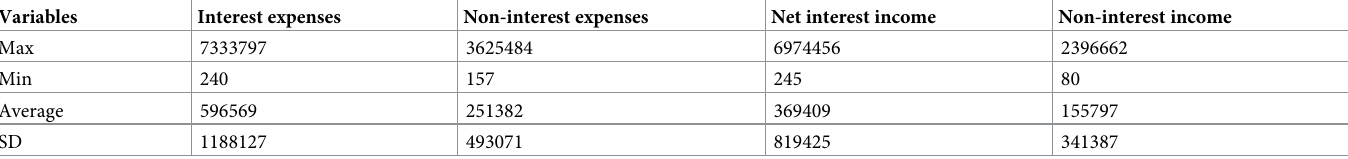
Table 3. Descriptive statistics of input-output variables (N = 147).